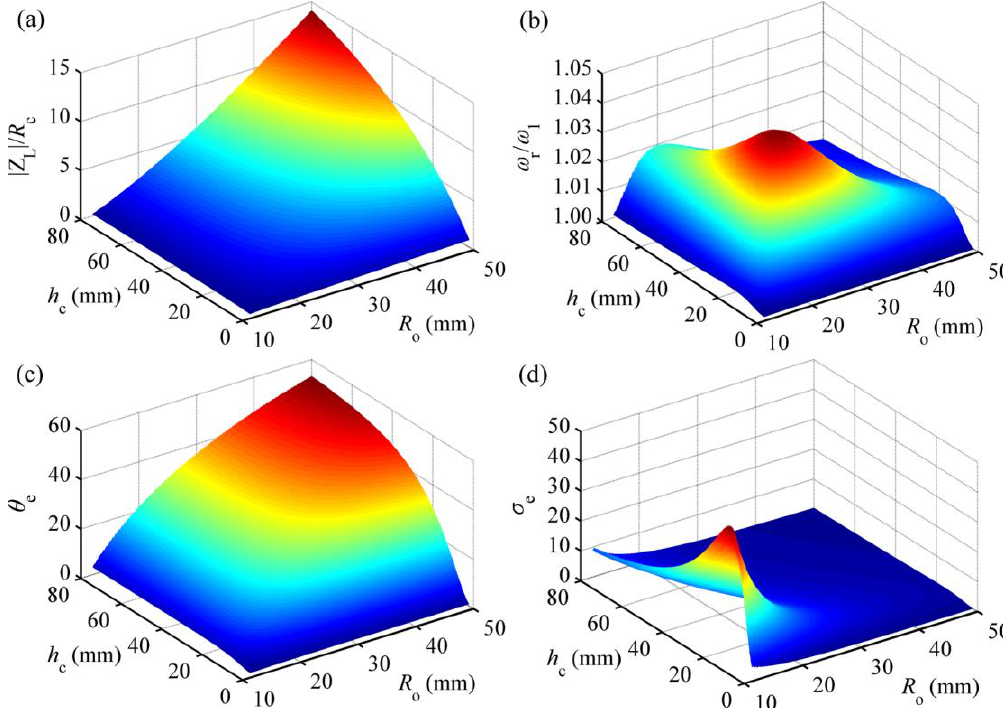
Figure 8. Performance of the HEH for different h c and R o : ( a ) ratio of inductive reactance |Z L | to internal resistance R c of the coil; ( b ) ratio of resonant frequency ω r to undamped natural frequency ω 1 ; ( c ) electromagnetic coupling coefficient θ e ; ( d ) electromagnetic coupling factor σ e .